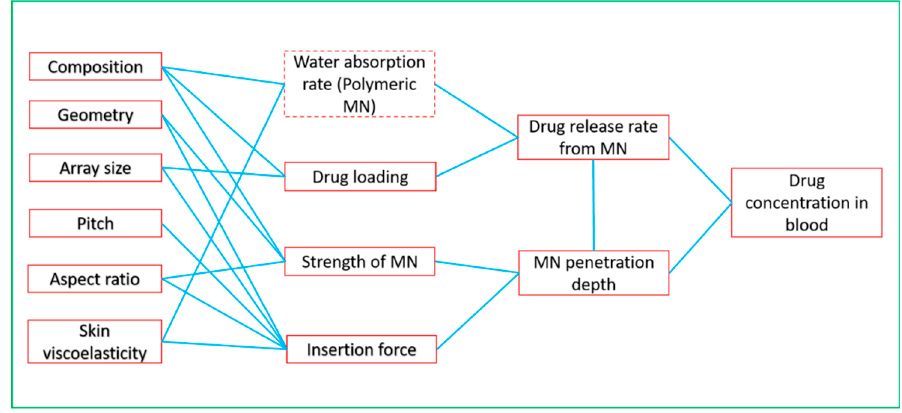
Figure 7. Relationship between skin and MN design parameters and therapeutic efficacy.